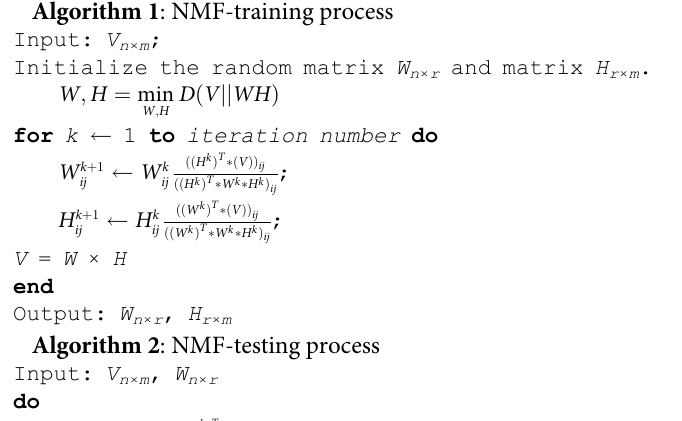
Algorithm 1 : NMF-training process